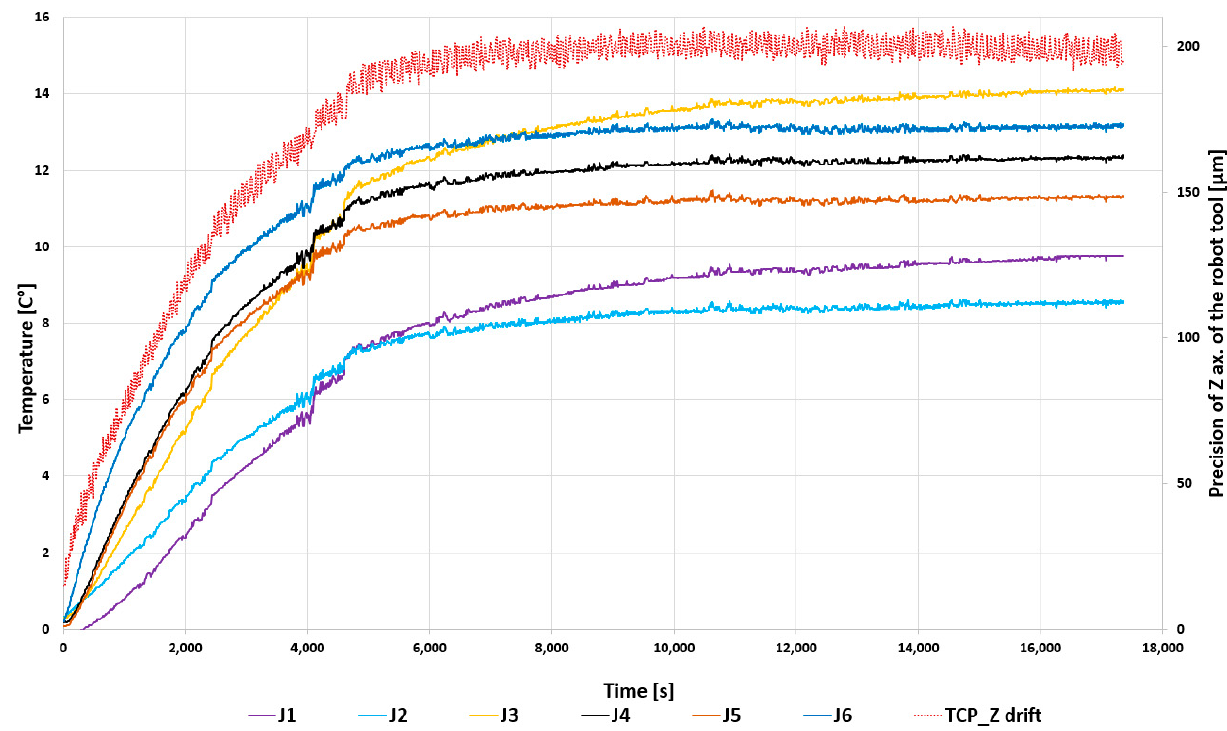
Figure 6. TCP Z-axis drift measurement, Target 1, maximum speed. Data recorded during the initial measurement: purple—joint 1 temperature, light blue—joint 2 temperature, yellow—joint 3 temperature, black—joint 4 temperature, orange—joint 5 temperature, dark blue—joint 6 temperature, red-dots express the trend of TCP Z-axis drift.